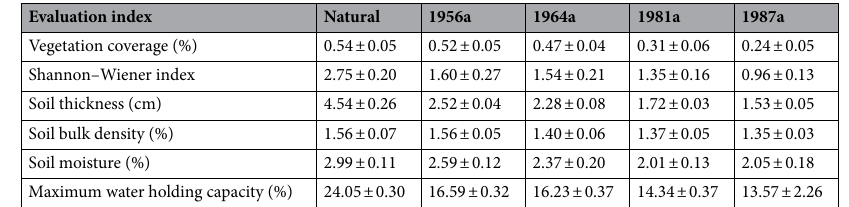
Table 3. The Bootstrap estimation of the population mean and standard deviation of each evaluation